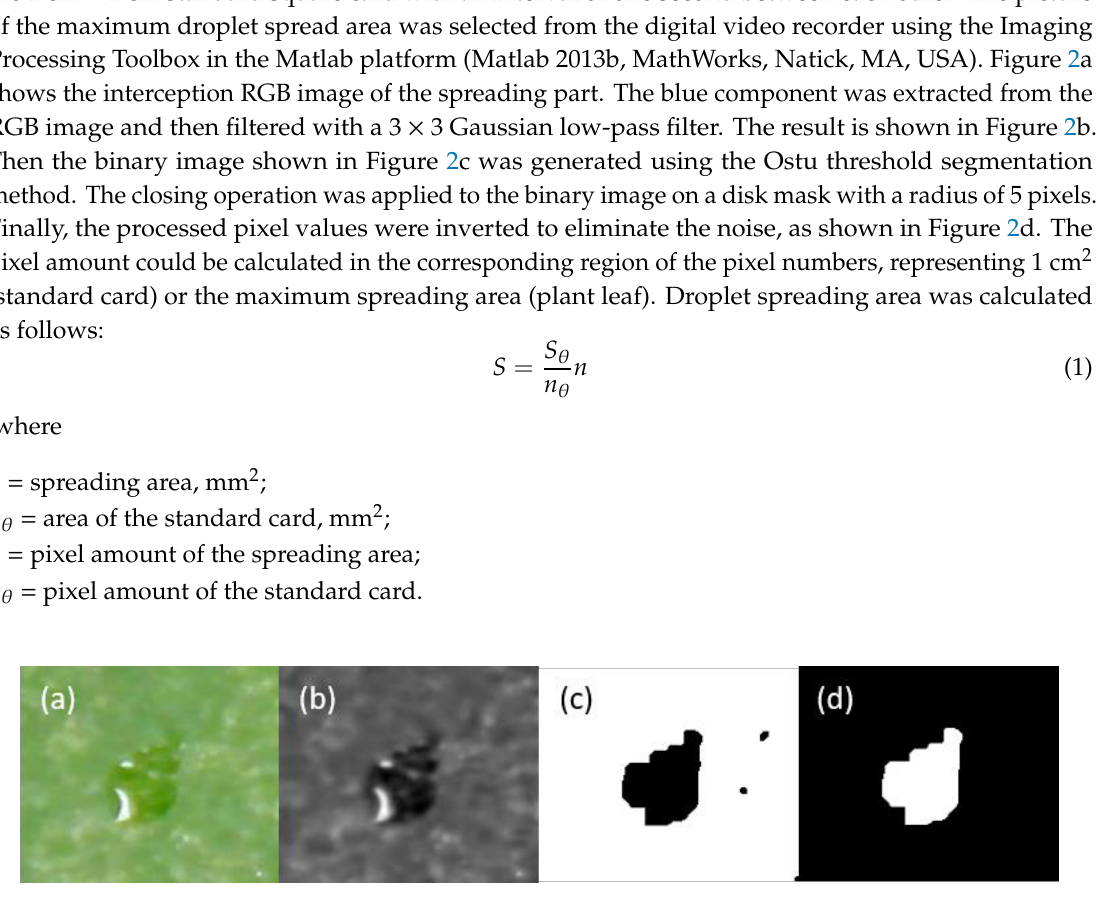
Figure 2. Comparison of the imaging processing procedure: ( a ) is the original RGB image, ( b ) is the blue component of the RGB image, ( c ) is the binary image generated from the Ostu threshold segmentation, and ( d ) is the result of the closing operation and the inversion operation of the binary image.